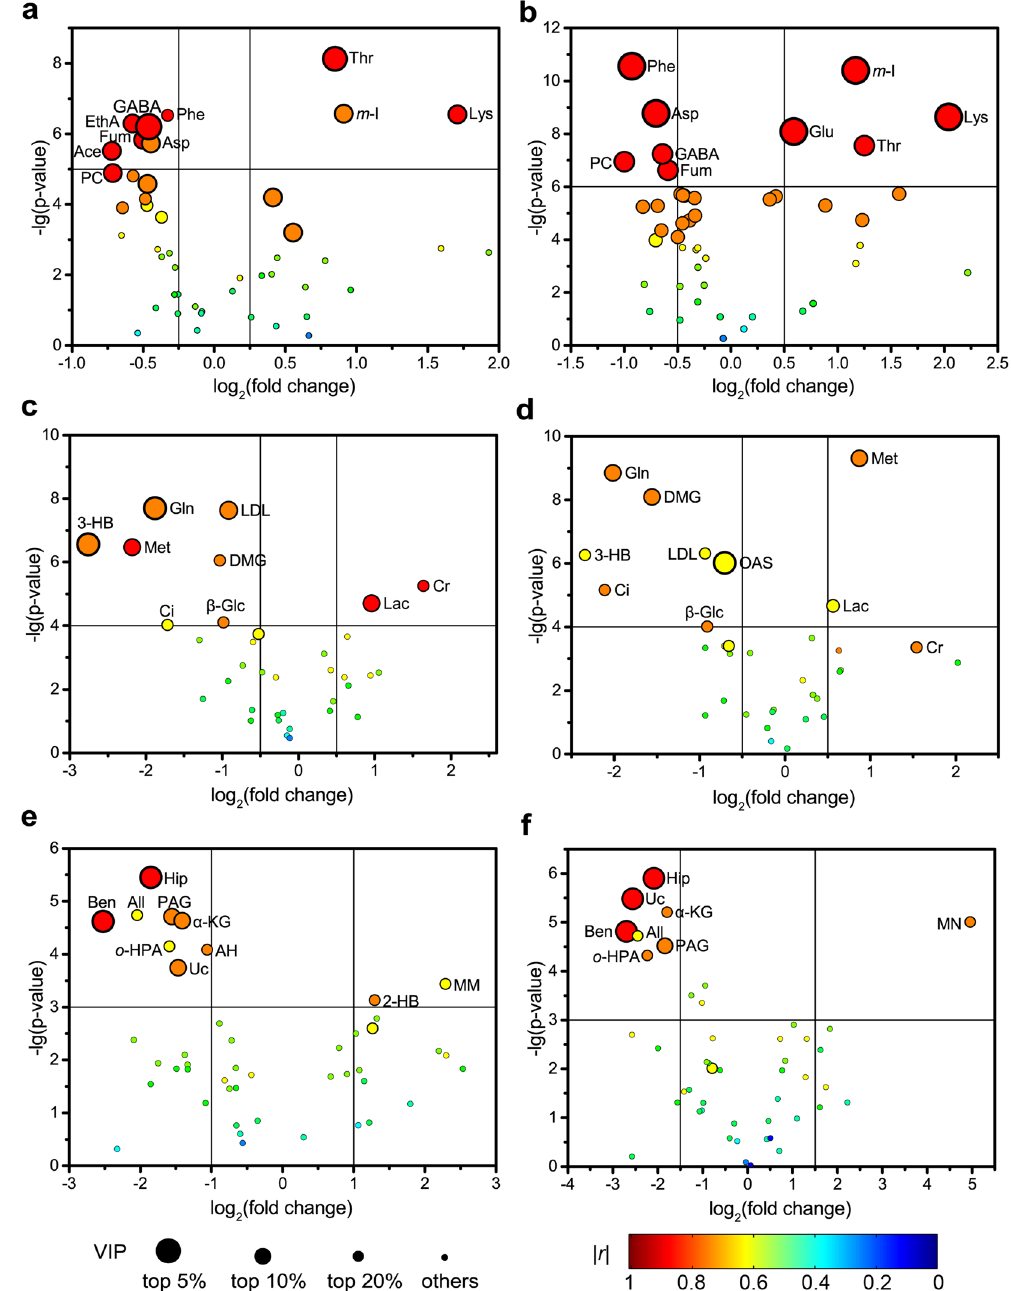
Figure 5. Enhanced volcano plots of multiple matrices for screening if metabolite markers. Figures ( a , c , e ) show comparison between SMFY and control groups, and ( b , d , f ) between GMFS and control groups; ( a and b ), ( c and d ), and ( e and f ) correspond to cortex extract, serum, and urine samples, respectively. VIP together with | r | is introduced with being represented by circles size and colour, respectively. For each comparison, VIP values are categorized into four segments: top 5%, top 10%, top 20% and rest 80%, with each represented by a circle of decreasing